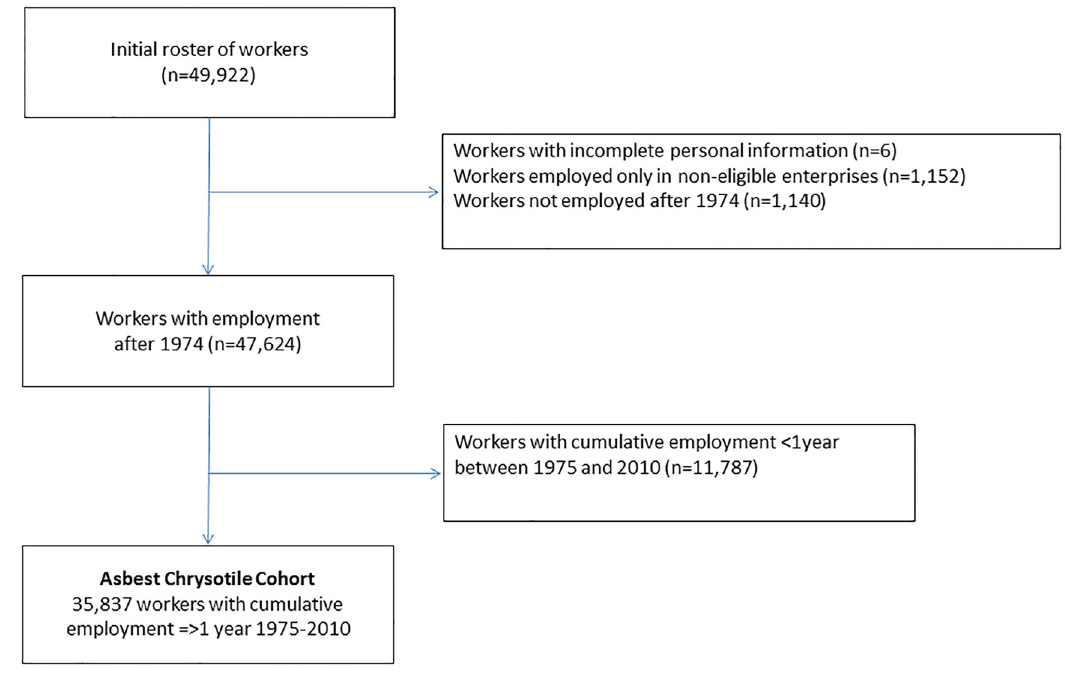
Fig 2. Flow chart of enrolment in the Asbest Chrysotile Cohort